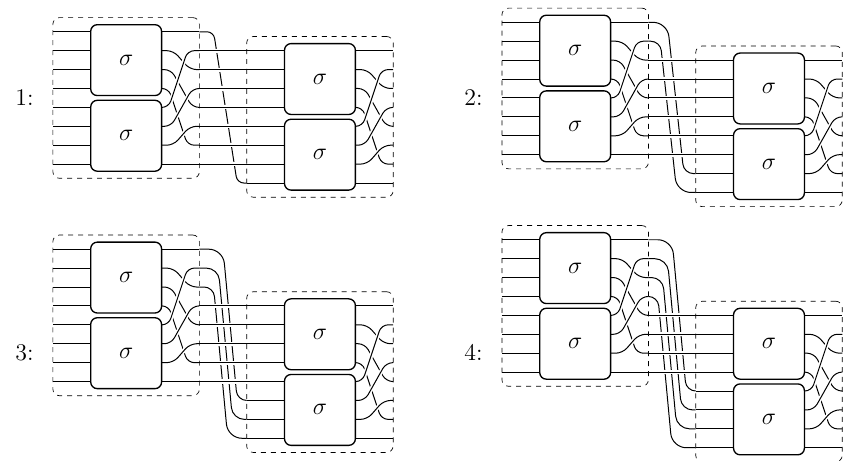
Figure 7: Alignment of Output and Input Bits of Consecutive Instances of the 8-bit Composite